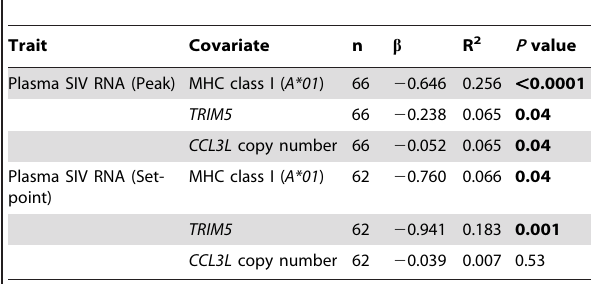
Table 1. Regressions with single covariates.